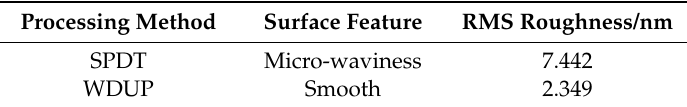
Figure 3. Topography of KDP crystal surface ( a ) Machined by single point diamond turning (SPDT) (PV 43.209 nm, RMS 7.542 nm); ( b ) Machined by water dissolution ultra-precision polishing (WDUP) (PV 21.555 nm, RMS 2.462 nm). Table 1. Averaged surface Root Mean Square (RMS) roughness of processed KDP samples (6 crystals in each group).